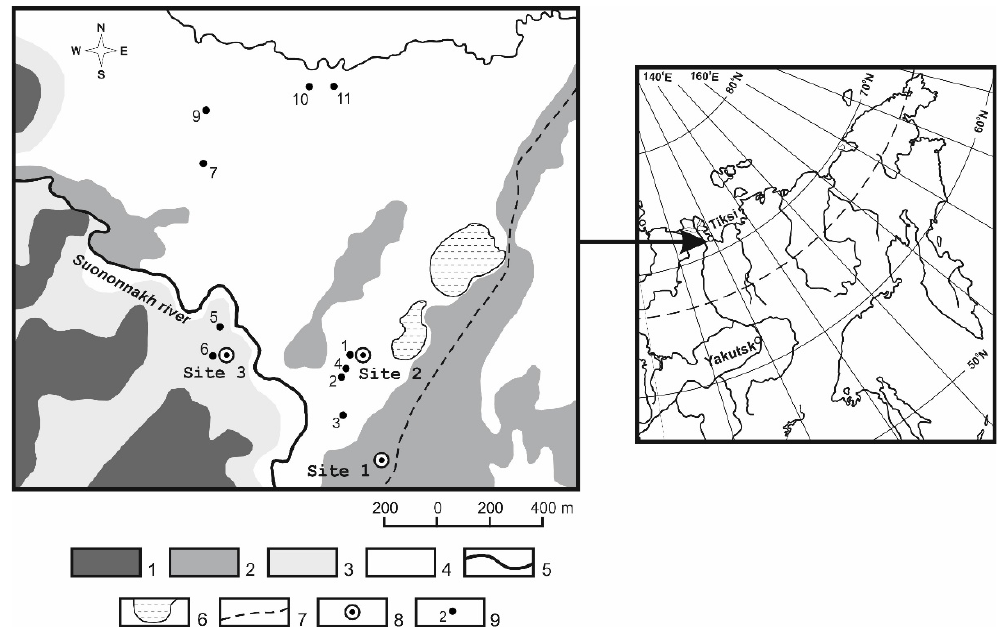
Figure 1. Map of the study area. 1—hills; 2—stone ridges; 3—gentle slopes; 4—foothill plain; 5—streams; 6—lakes; 7—road; 8—ground temperature monitoring sites; 9—active-layer measurement sites.